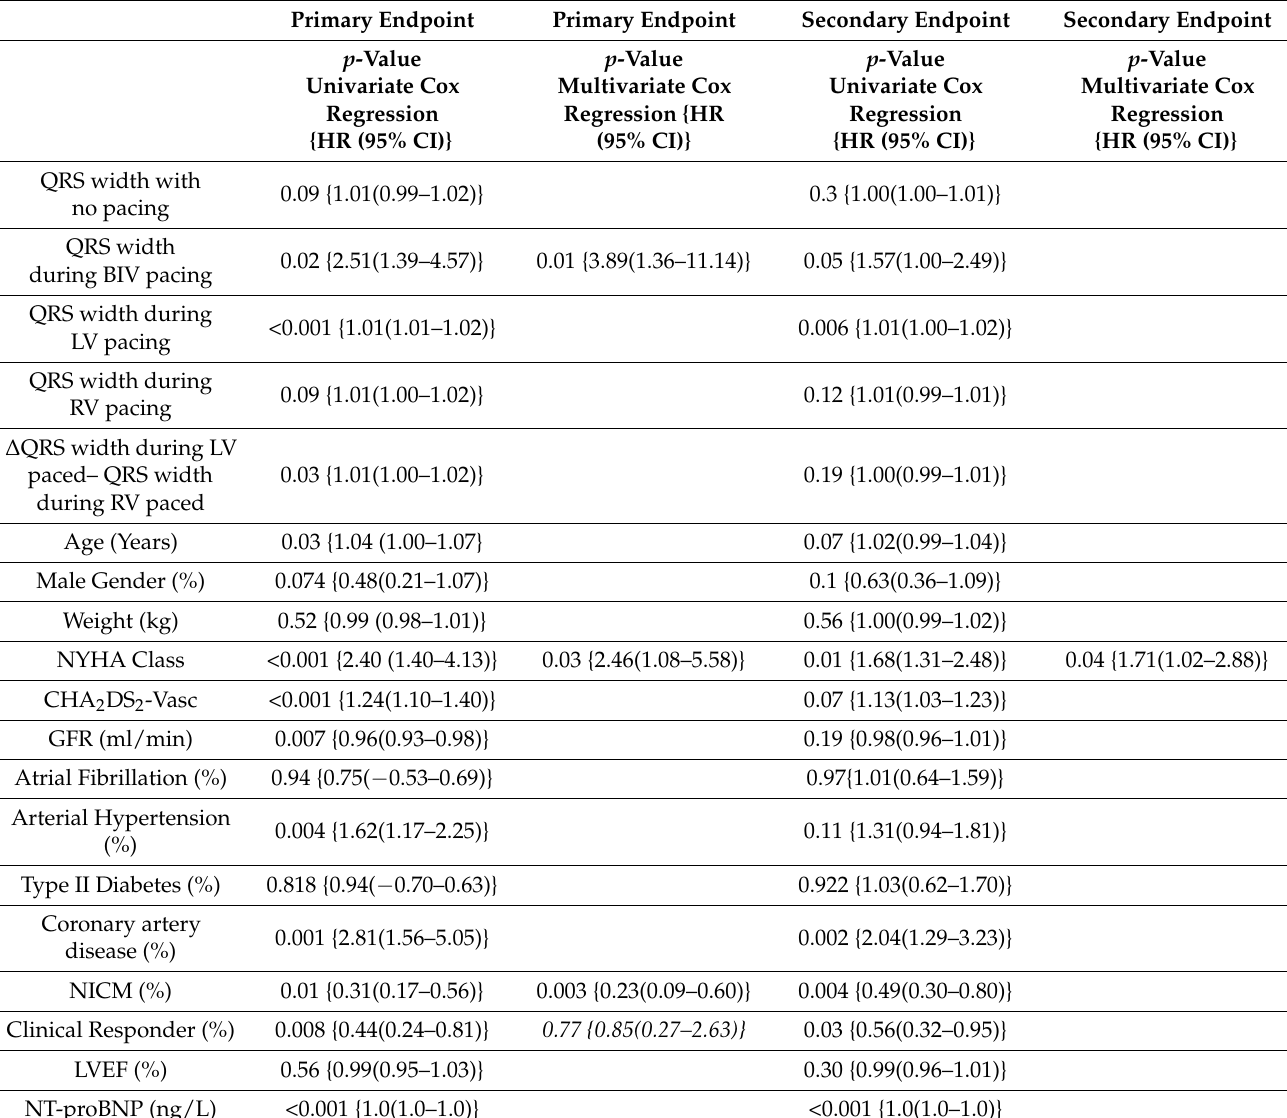
Table 2. Uni- and multivariate Cox regression for the primary and secondary endpoints of patient characteristics at the time of implantation and ECG parameters (BIV: bBiventricular; LV: left ventricular; RV: right ventricular; ∆ : difference; NYHA: New York Heart Association; GFR: glomerular filtration rate; NICM: non-ischemic cardiomyopathy; ng/L: nanogram per liter; LVEF: left ventricular ejection fraction; HR: hazard ratio; 95% CI: 95% confidence